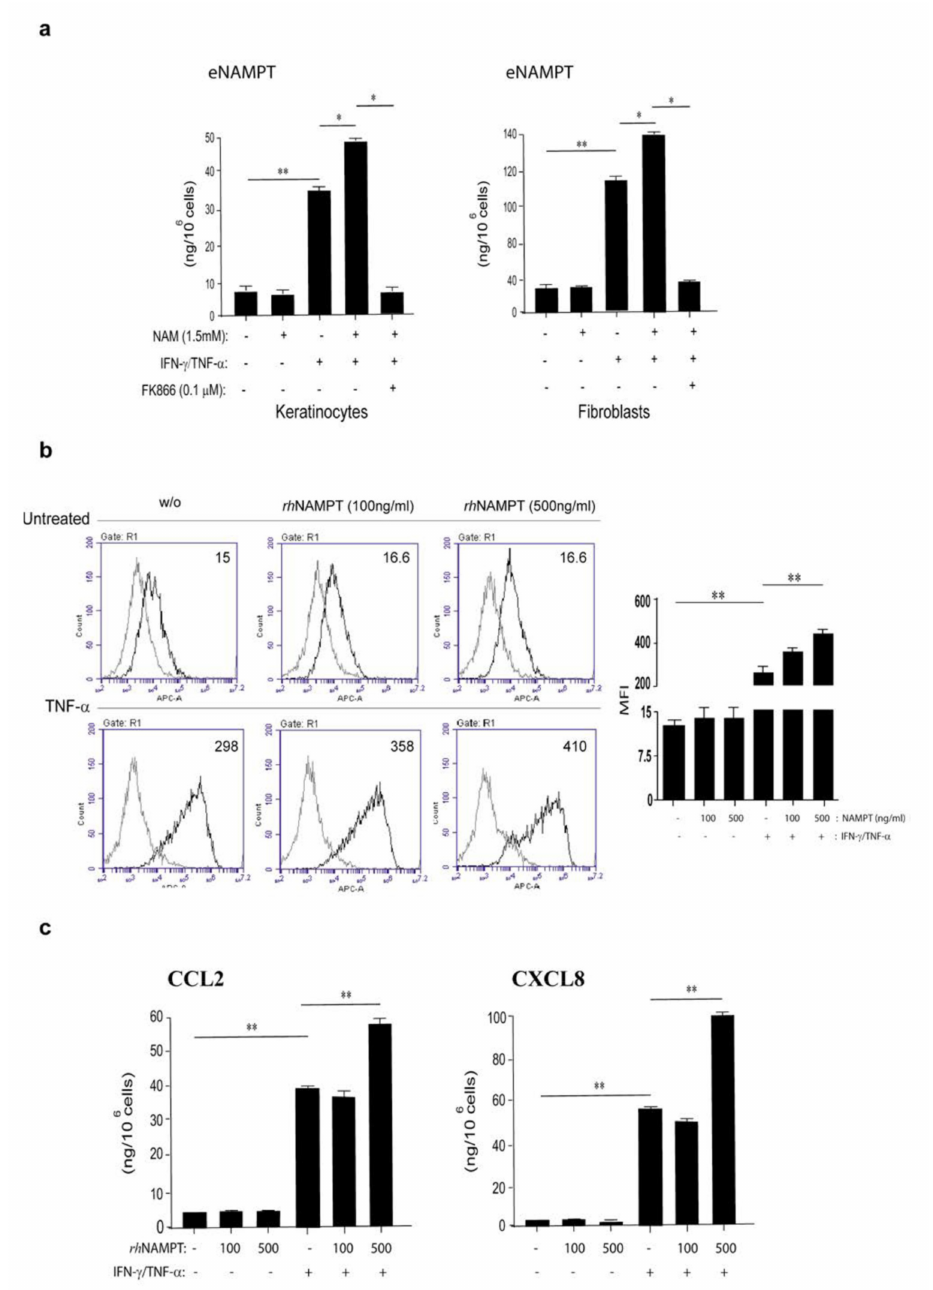
Figure 6. The release of extracellular NAMPT is strongly induced by pro-inflammatory cytokines and it is strictly regulated by intracellular NAD + metabolism. ( a ) Extracellular NAMPT (eNAMPT) release was analyzed by ELISA in supernatants obtained by keratinocyte and fibroblasts left untreated or treated with a combination of IFN- γ /TNF- α in presence or absence of NAM (1.5 mM) for 24 h. When necessary, keratinocytes and fibroblasts activated by cytokines were concomitantly exposed to NAM and FK866 (0.1 µ M) for 24 h. Data are expressed as mean of three independent experiments ± SD. * p ≤ 0.05 and ** p ≤ 0.01 by paired Student’s t test. ( b ) ICAM-1 expression was evaluated by flow cytometry analysis on HDMEC stimulated for 24 h with IFN- γ /TNF- α and treated or not with rh NAMPT at 100 ng/mL and 500 ng/mL. Data are shown as means of fluorescence intensity ± SD. ** p ≤ 0.01 by paired Student’s t test. ( c ) CCL2 and CXCL8 release was evaluated by ELISA on supernatants obtained from HDMEC cultures stimulated or not for 24 h with IFN- γ /TNF- α - in presence or not of rh NAMPT (100 ng/mL and 500 ng/mL). Data are expressed as mean of three independent experiments ± SD. ** p ≤ 0.01 was calculated by paired Student’s t